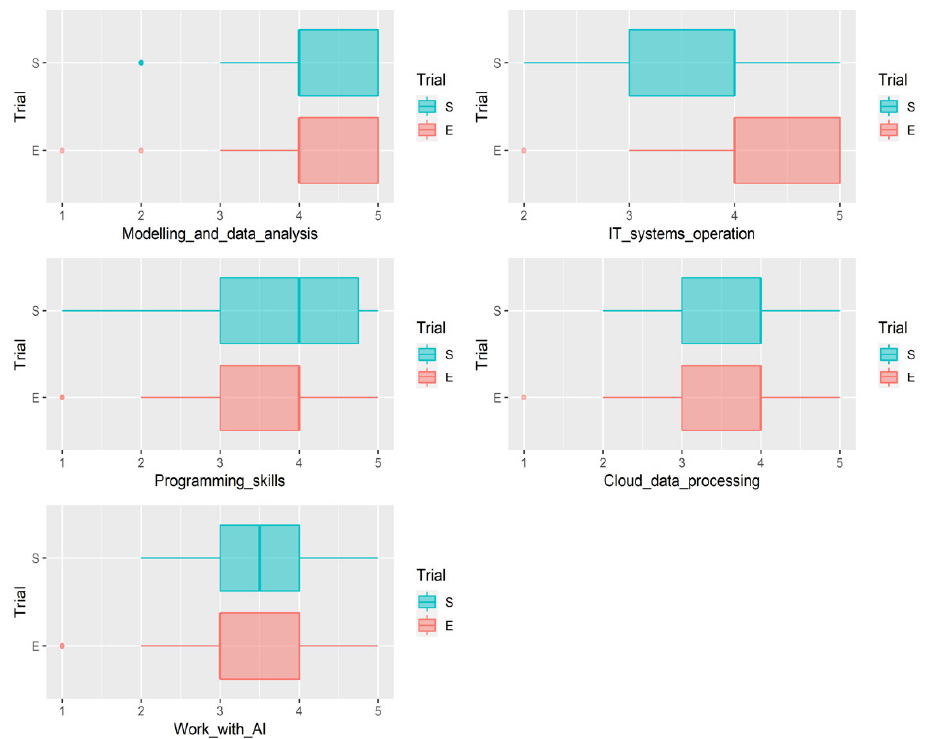
Figure 3. Assessments of digital competencies in the trials (1—not important, 5—very important). Note: student trial is marked as S, employee trial is marked as E. Source: own elaboration.